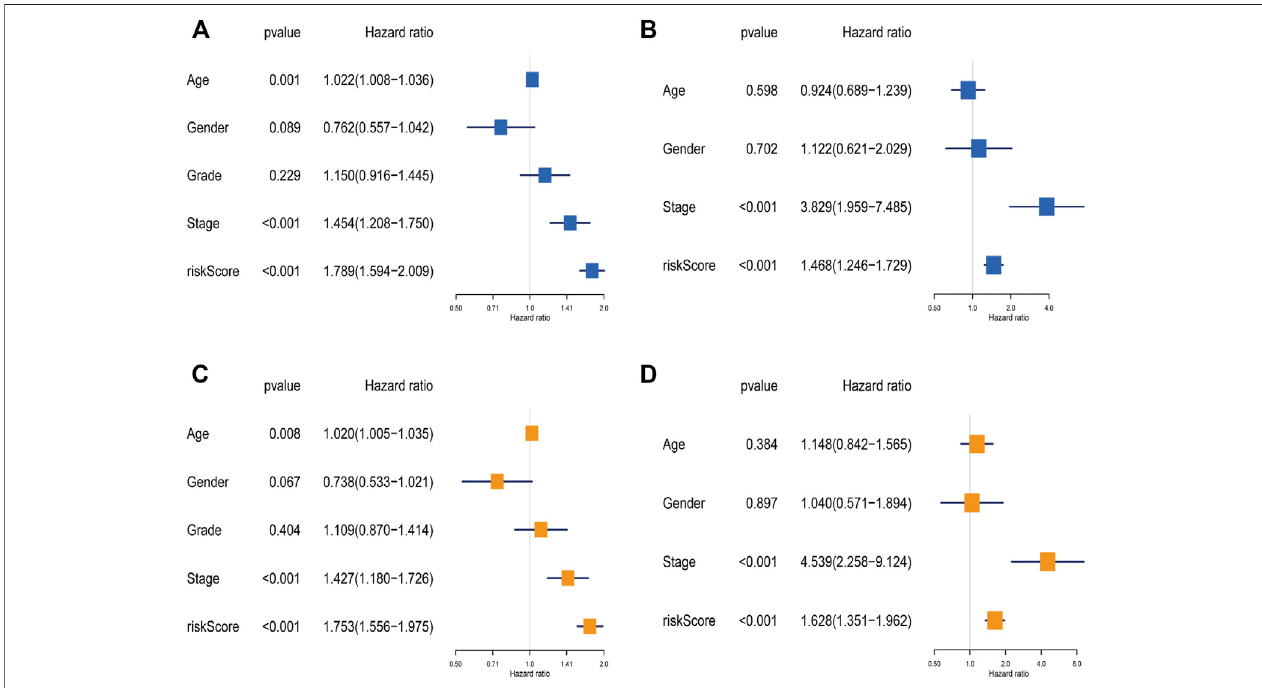
FIGURE 5 | The independence identi fi cation of the risk model. Univariate cox regression analysis and multivariate cox regression analysis were performed in The Cancer Genome Atlas data set (A,C) and the Gene Expression Omnibus data set (B,D) .